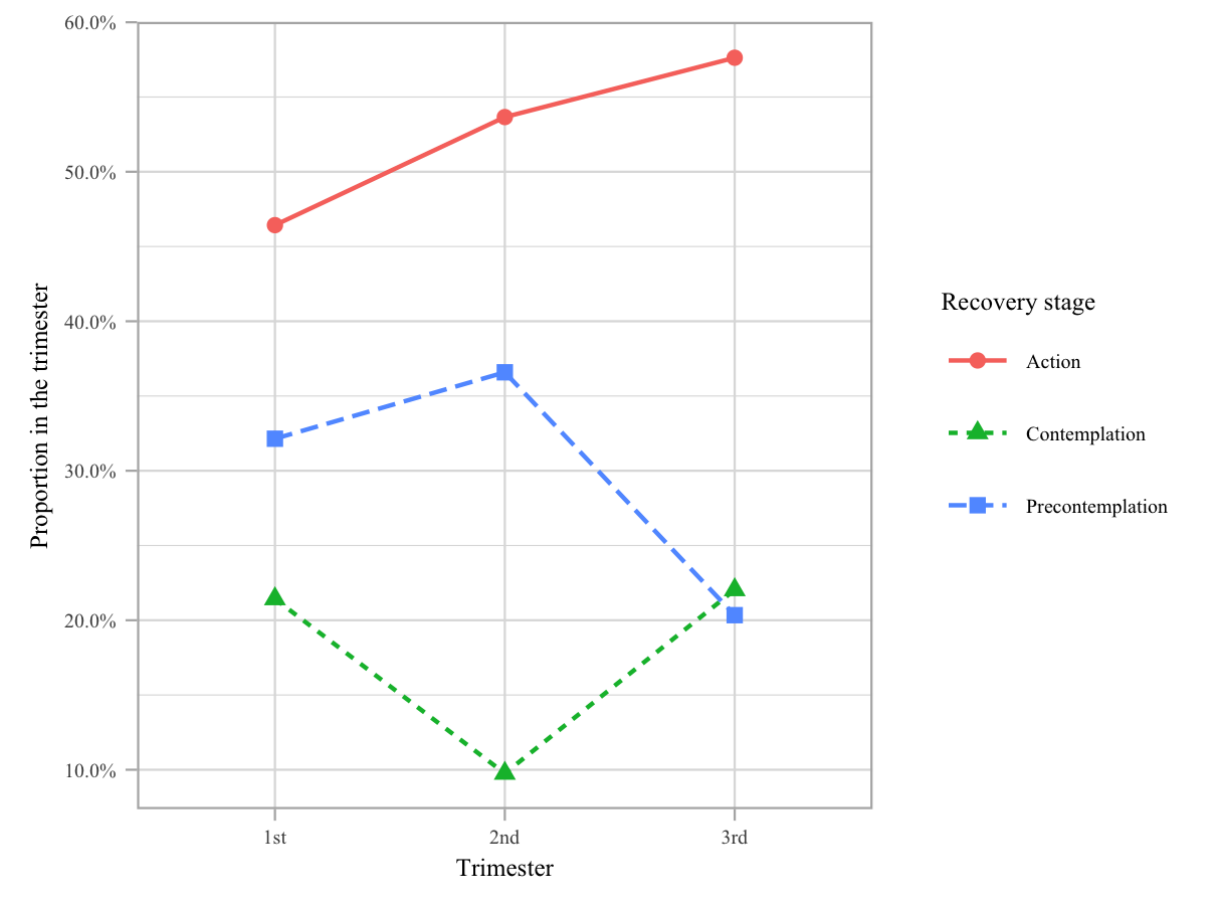
Figure 1. Proportions of the recovery stages by